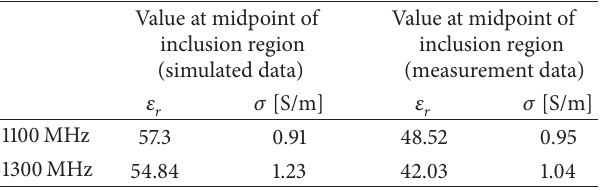
Table 2: Recovered dielectric properties values at the midpoint of the inclusion region for the simulated and measured data (1100 and 1300